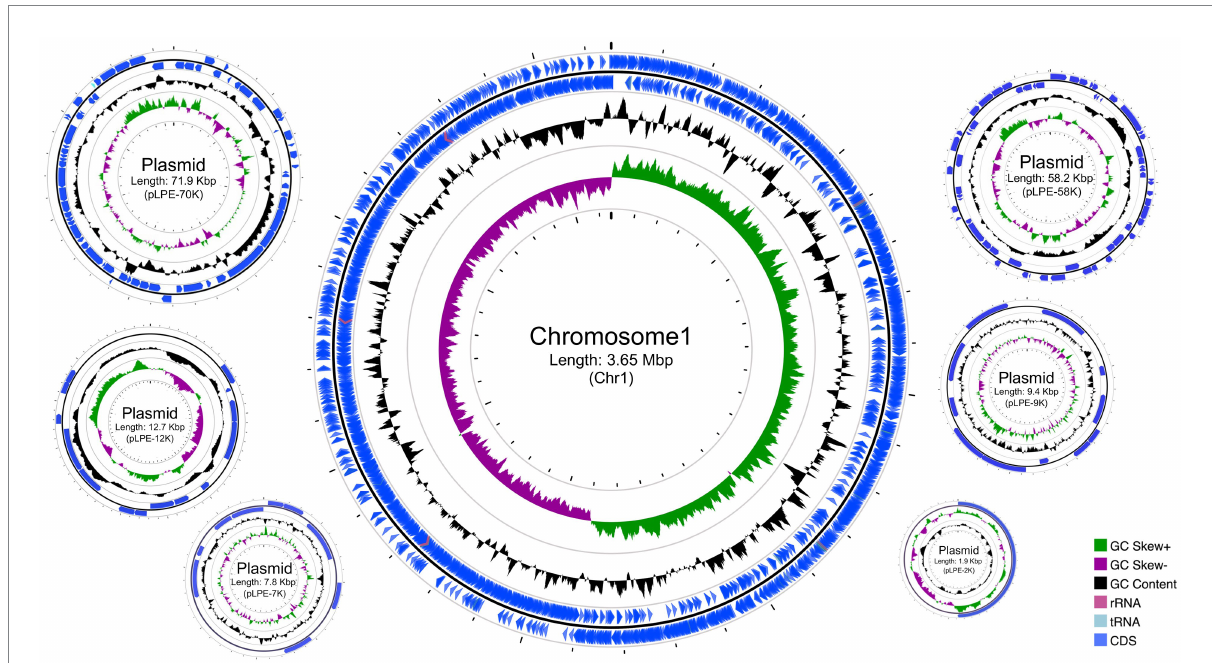
FIGURE 1 Circular genome maps of Lactiplantibacillus pentosus 9D3. From outside to center: Rings 1 and 2 demonstrate the protein-coding genes (CDS) (blue), tRNA (light blue), and rRNA (light purple) on the forward and reverse strands, respectively; ring 3 represents the GC content plot; ring 4 represents the positive and negative GC skew in green and purple,